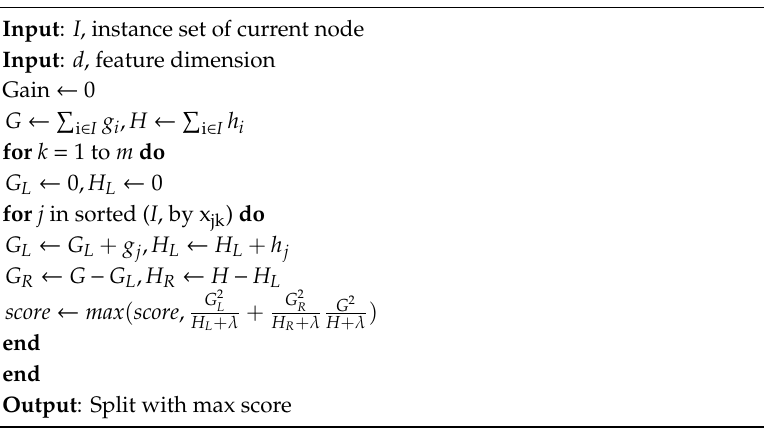
Algorithm 4. Extreme gradient boosting (XGBoost)